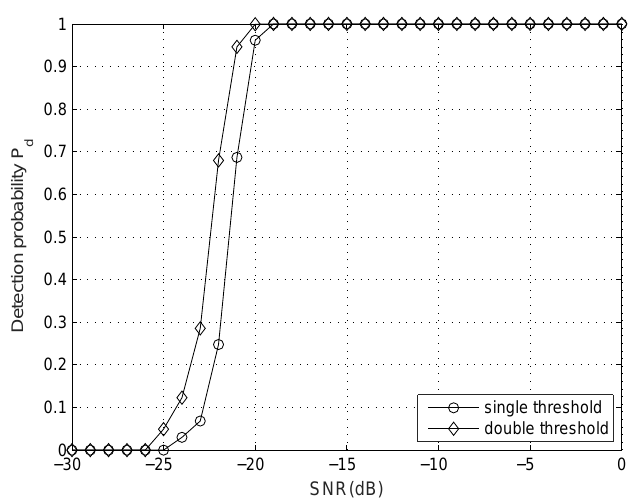
Figure 7. Detection performance comparison of the proposed algorithm with the single threshold detection.